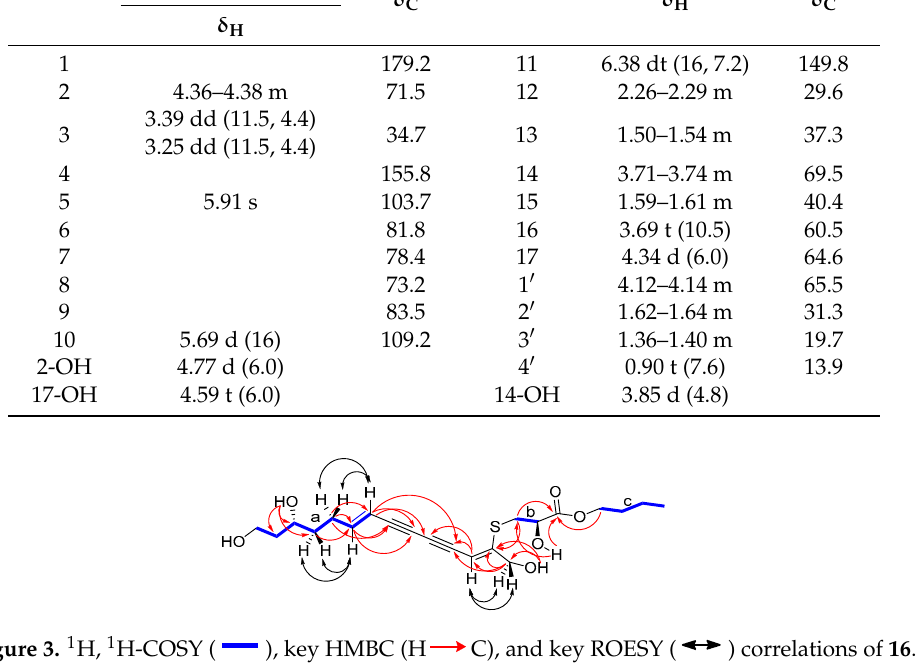
correlations of 16 .